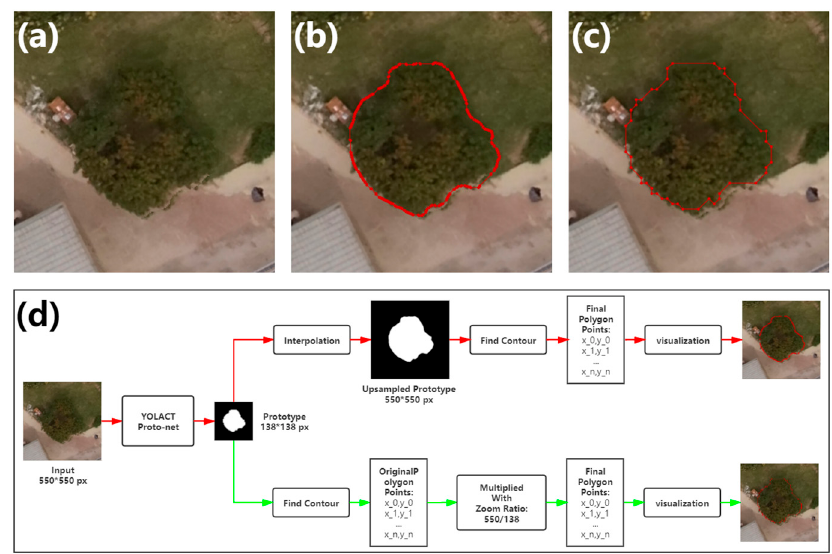
Figure 7. Illustration of contour extraction. ( a ) The example of the litchi canopy image. ( b , c ) The visualization of the contours extracted by the original implementation and the method proposed in this paper. ( d ) Workflows of contour extraction. The red line represents the original implementation, while the green represents the method proposed in this paper.